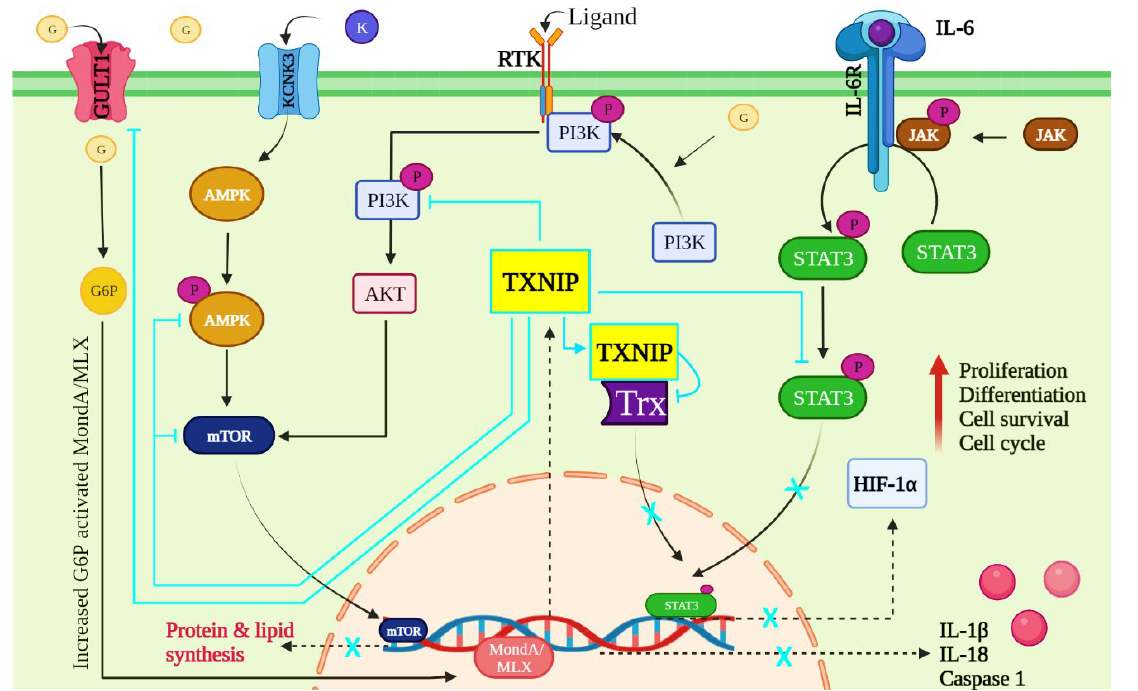
Figure 3. Schematic representation of TXNIP in mediating signaling pathway in cancer impediments. This picture represents how TXNIP is involved in cancer suppression via JAK/STAT, AMPK/mTOR, and PI3K/AKT signaling pathways. Note: Interleukins; JAK: Janus kinase; STAT: signal transducer and activator of transcription; HIF: Hypoxia-inducible factors; TXNIP: Thioredoxin-interacting protein; Trx: Thioredoxin; PI3K: Phosphatidylinositol 3 kinase; AKT: Protein Kinase B; RTK: Receptor tyrosine kinase; KCNK3: Potassium Channel, Subfamily K, Member 3; AMPK: AMP-activated protein kinase; mTOR: Mammalian target of rapamycin; GLUT1: Glucose transporter 1; G: Glucose; G6P: Glucose 6 phosphate; K: Potassium; p: Phosphorylation. The black line/arrow represents the regulating pathway, and the blue line represents the inhibitory role.